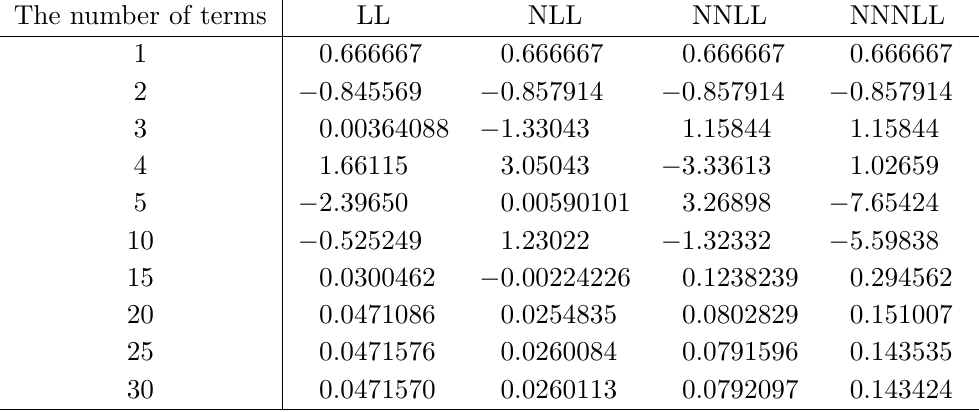
Table 2 . Estimates of the normalization constant N RG-improved series.